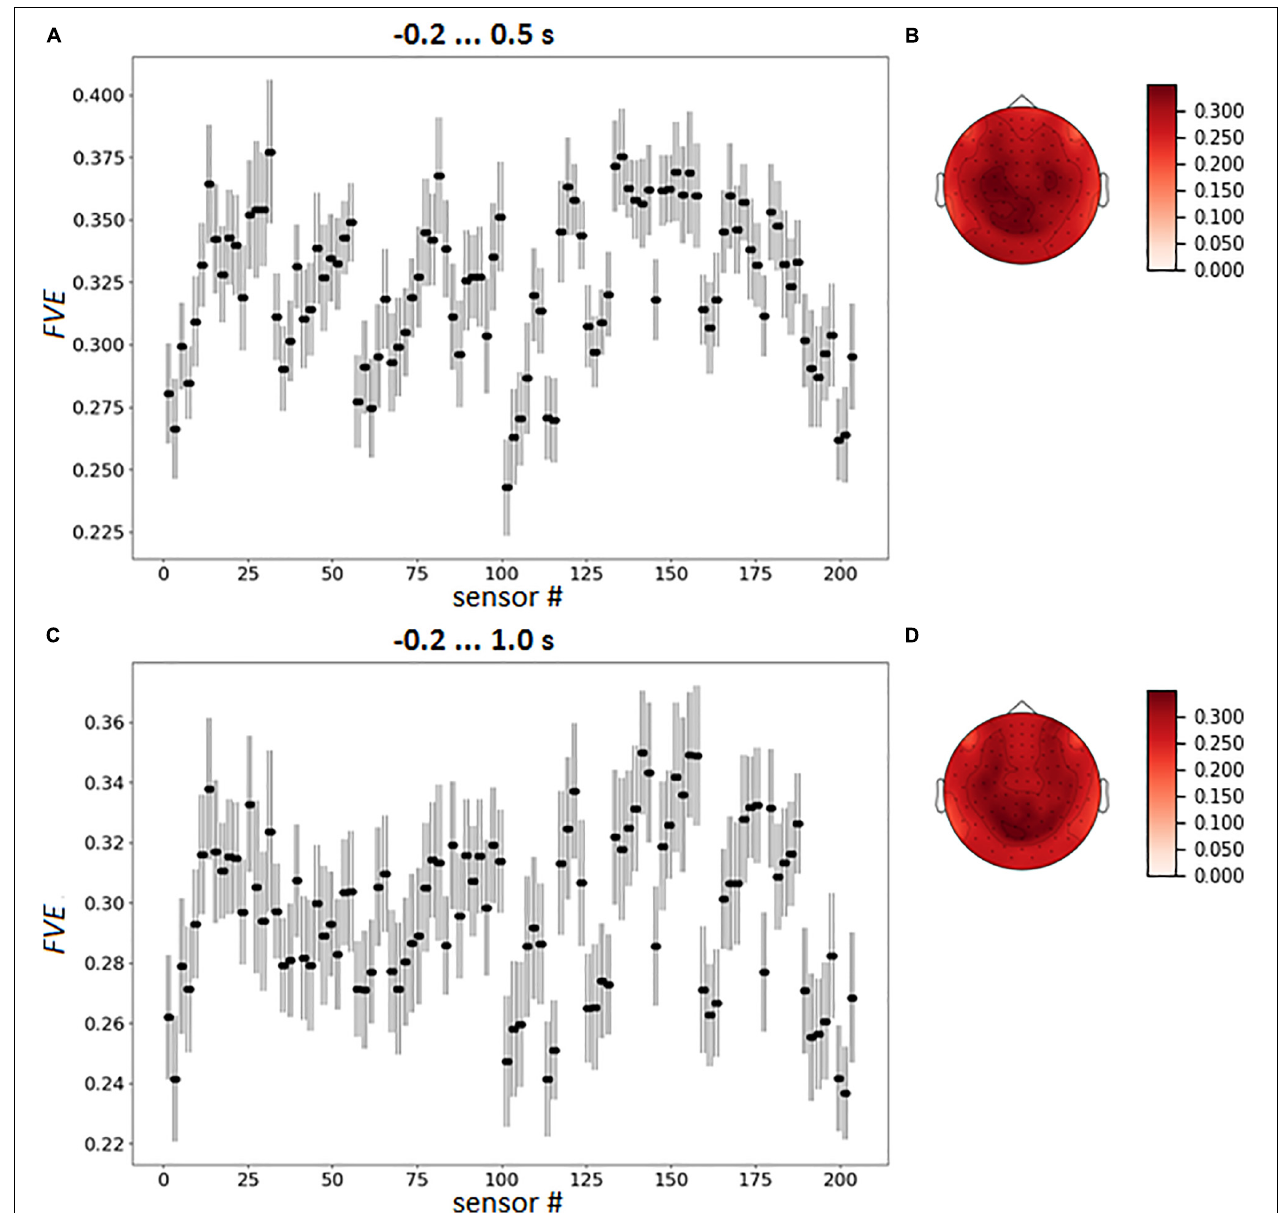
FIGURE 8 | Group mean FVE patterns, as point plot with 95% confidence intervals for every gradiometer (A,C) and as topographical maps (B,D) . The data were averaged over test folds for each participant prior to other